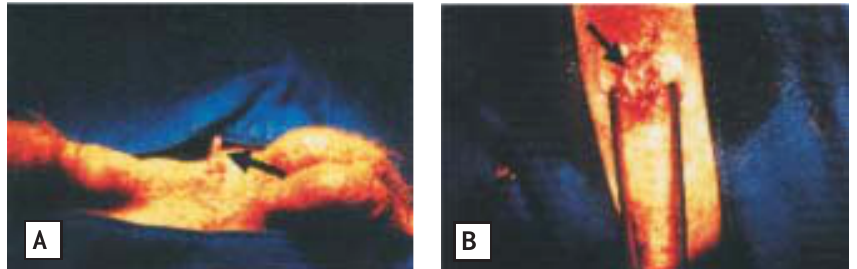
FIGURA 1 - Aspecto da uretrostomia aos 40 dias de pós-operatório, evidenciada pela exposição de sonda uretral pela fístula (A/seta). Retalho elíptico de mucosa bucal suturado às bordas do defeito uretral em padrão simples interrompido (B/seta).